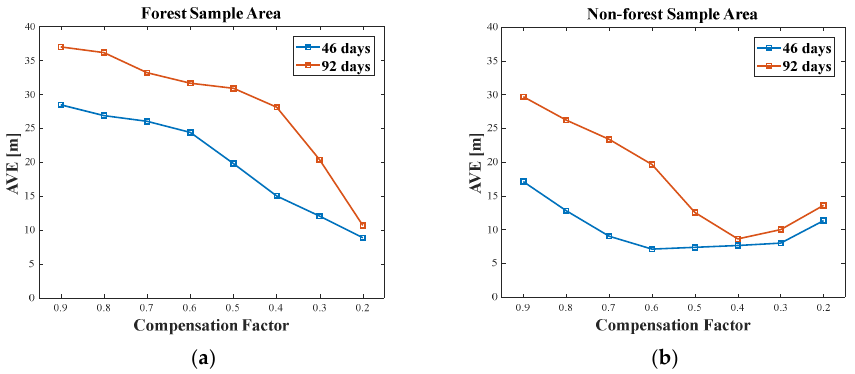
Figure 12. AVE variation versus different compensation factors: ( a ) forest sample area. ( b ) non-forest sample area.